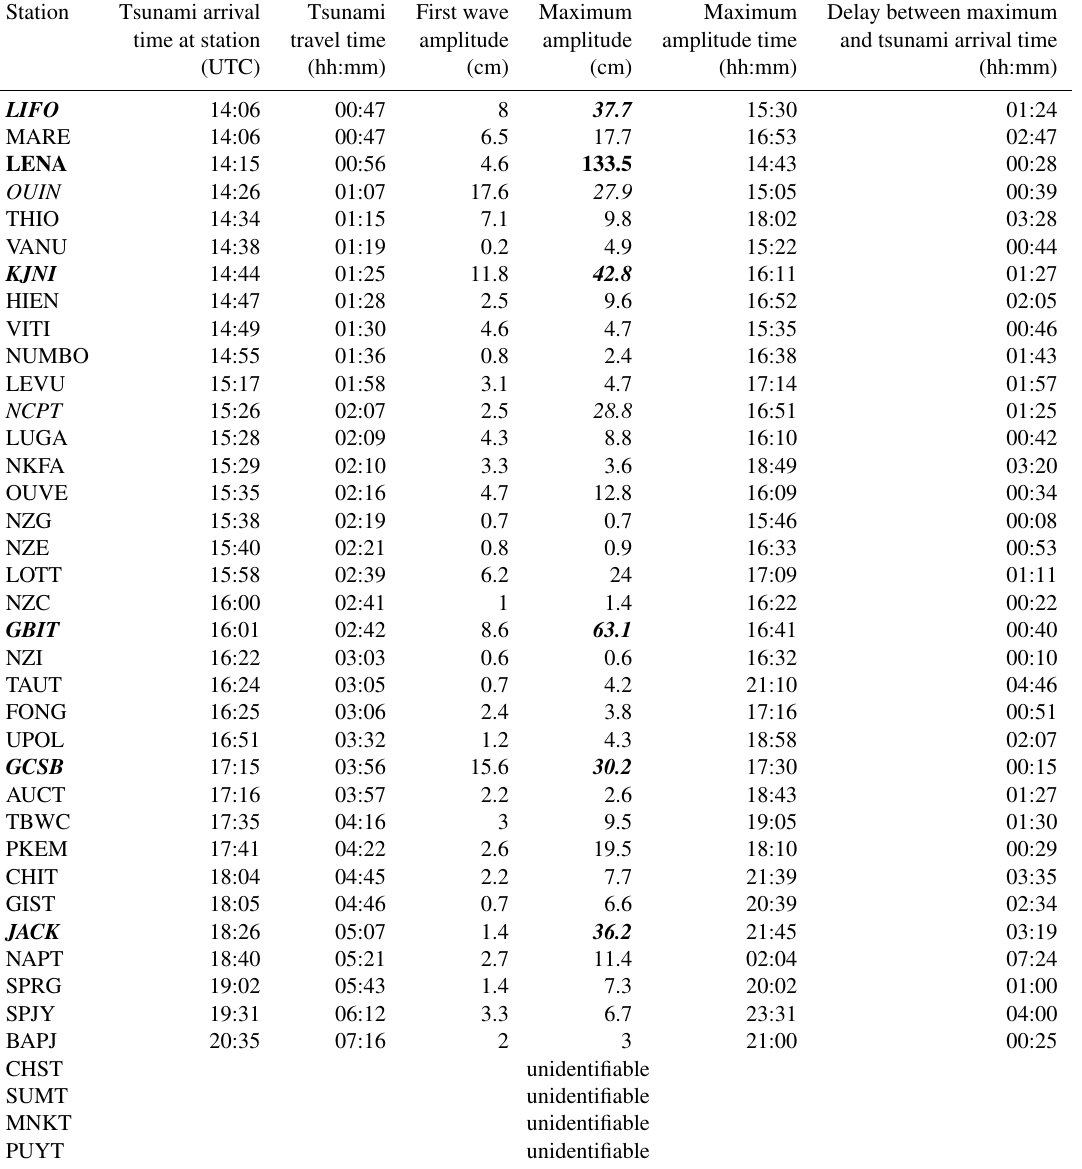
Table 2. Arrival times and amplitudes of the 10 February 2021 tsunami on DART stations and coastal gauges. They are classified from the first station (top row) recording the tsunami to the last one (bottom row). Coloured cells locate the stations which recorded wave amplitude of nearly 30cm (italic), more than 30cm (bold-italic), and more than 1m (bold).